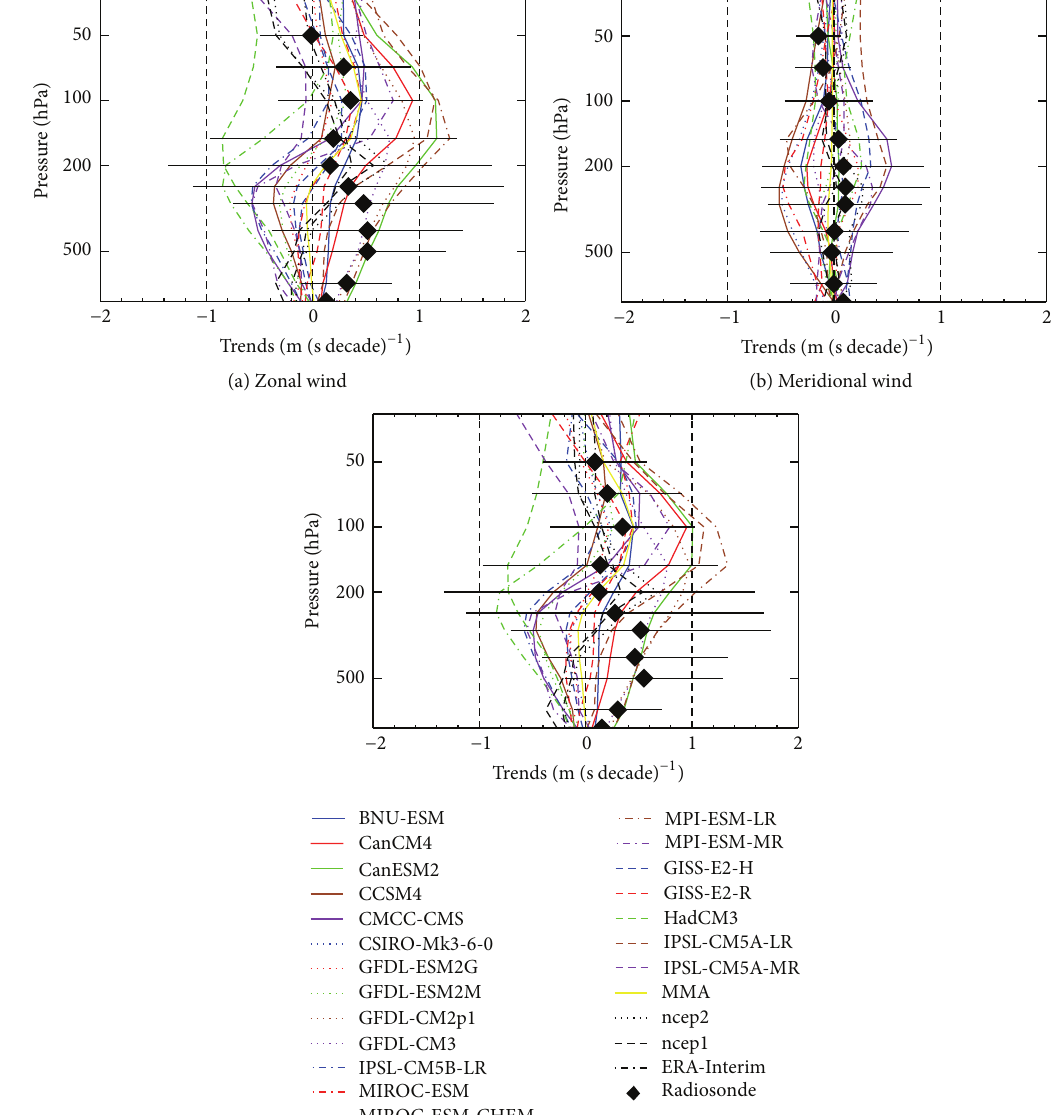
Figure 7: The vertical distributions of annual mean horizontal wind and wind speed trends from radiosonde, reanalysis, and CMIP5 models calculated for 1979–2005. Horizontal black line represents the 2-sigma variation in